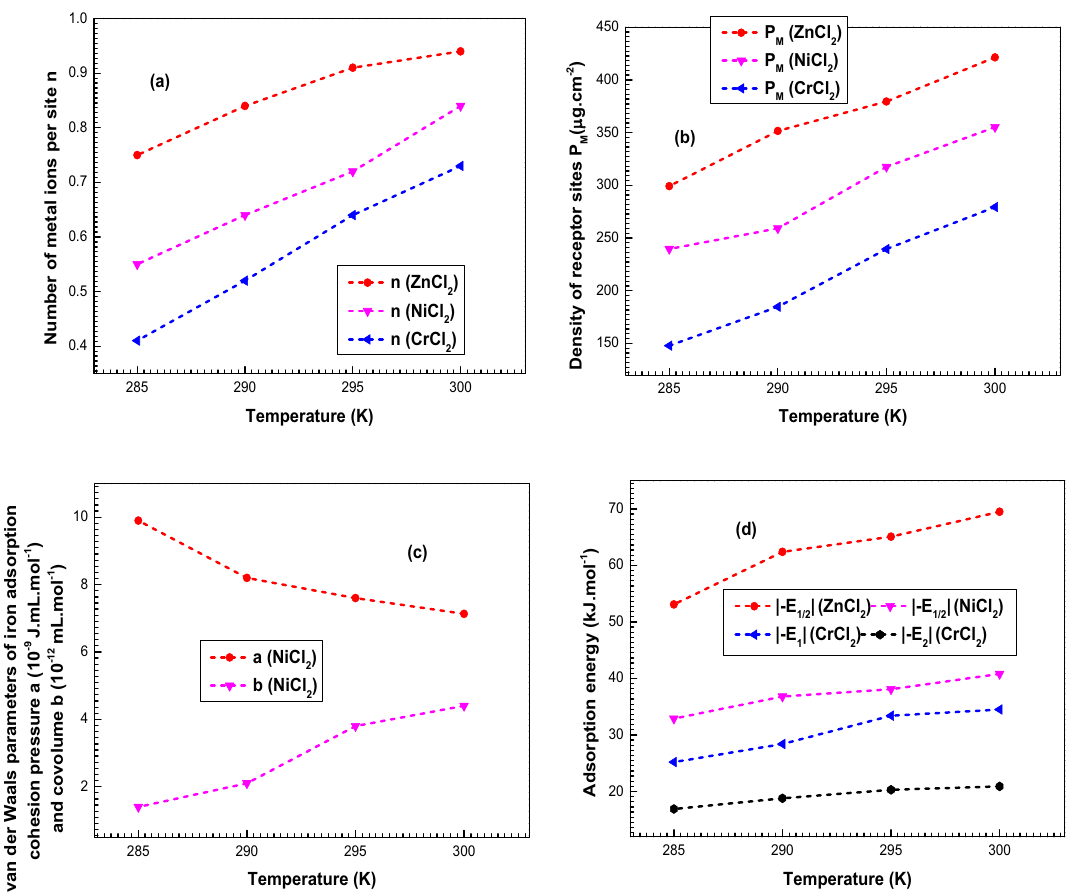
Figure 4. Evolutions of the two steric parameters ( (a) the number of metal ions per site n and (b) the density of receptor porphyrins sites P M ), the lateral interactions parameters (c) (cohesion pressure a and covolume b ) and the adsorption energies (d) (|− E 1/2 |, |− E 1 | and |(− E 2 )|) as a function of temperature (285–300